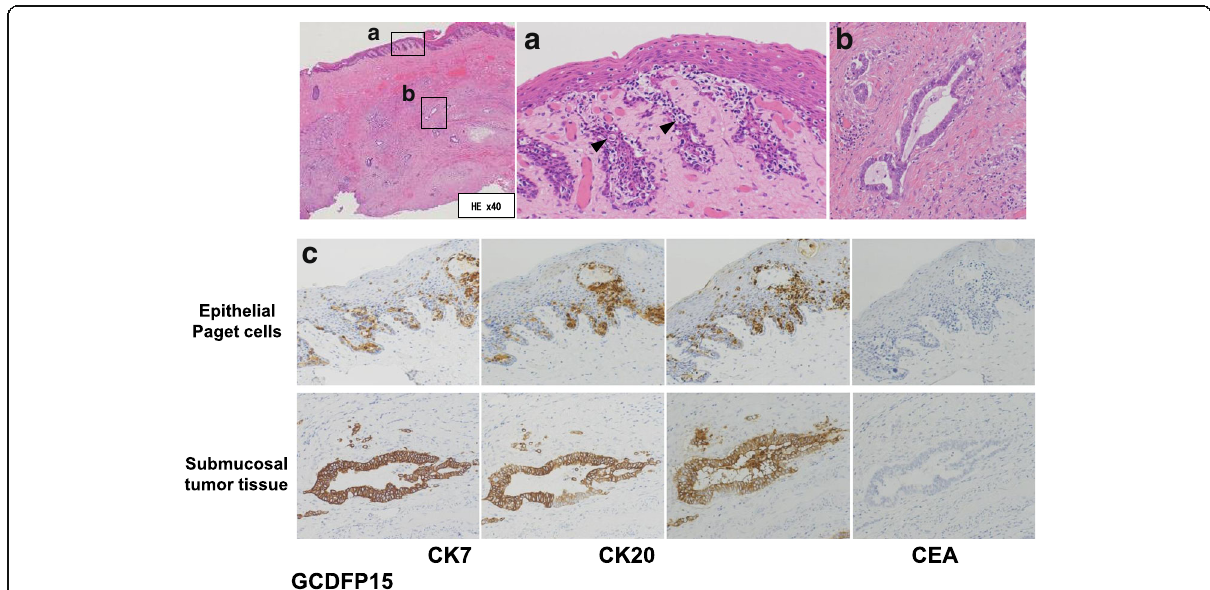
Fig. 2 Paget cells were scattered in squamous epithelium ( arrow head ) ( a ) (HE ×200). Adenocarcinoma tissue was observed in the submucosa ( b ) (HE, ×200). Immunohistochemical staining revealed that CK7, CK20, and CEA expression was positive in epithelial Paget cells and submucosal adenocarcinoma tissues. However, GCDFP-15 activity was not detected in any lesions ( c ) (×200)